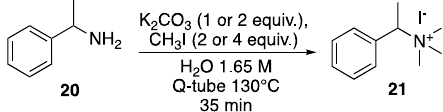
10 Table 3. Scope of the N -arylation reaction. Entry Heterocycles (11 – 13) Electrophile